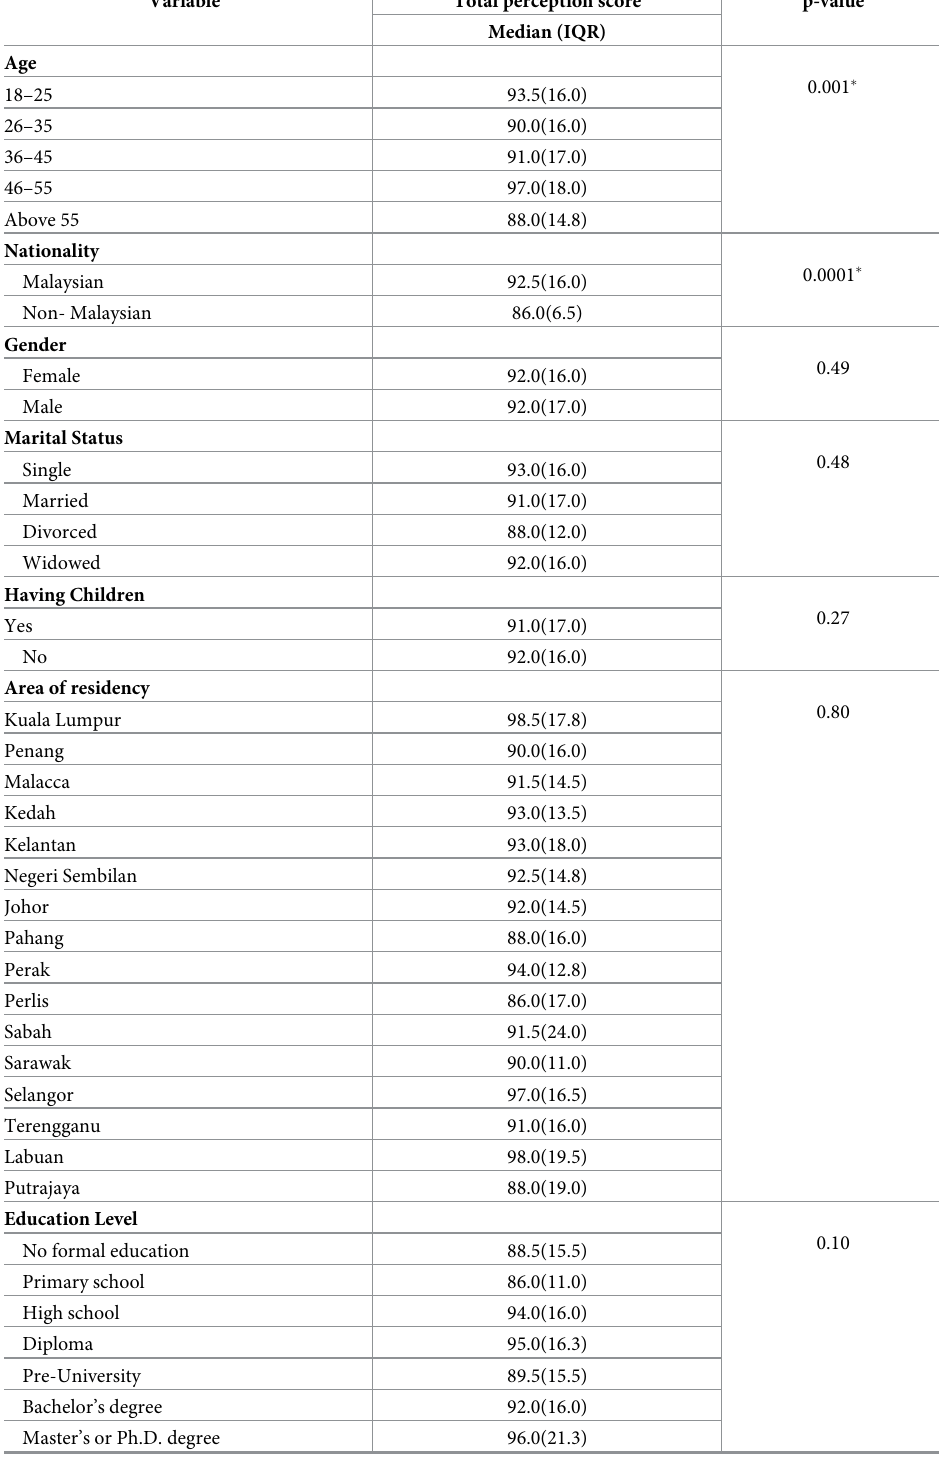
Table 6. Association between perceptions and sociodemographic factors among the general population (N =